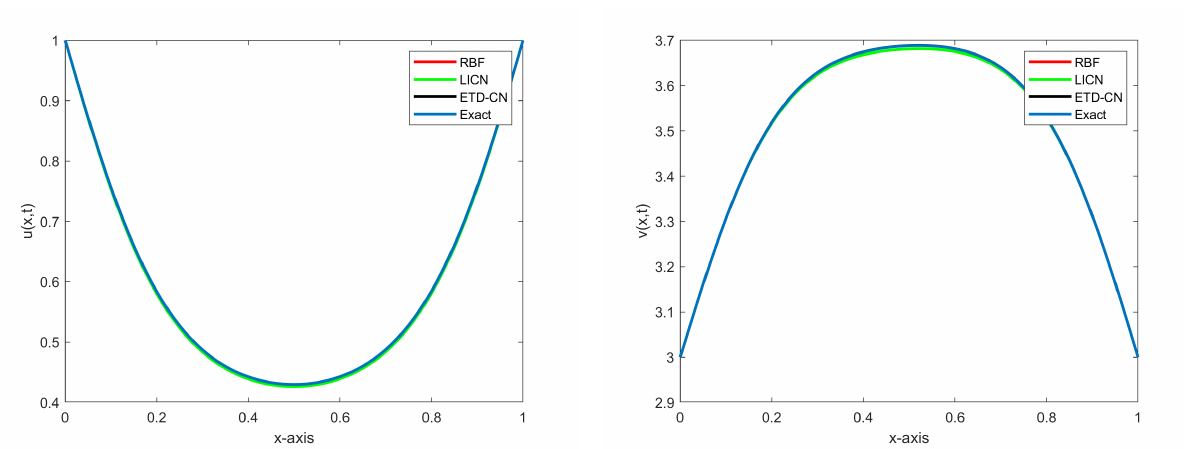
Figure 2. Numerical solutions (obtained by the schemes LICN, ETD-CN, MQRBF) corresponding to h = 0.0125 ( N = 81 ) and k = 0.0125 at t = 10 versus analytical solution.